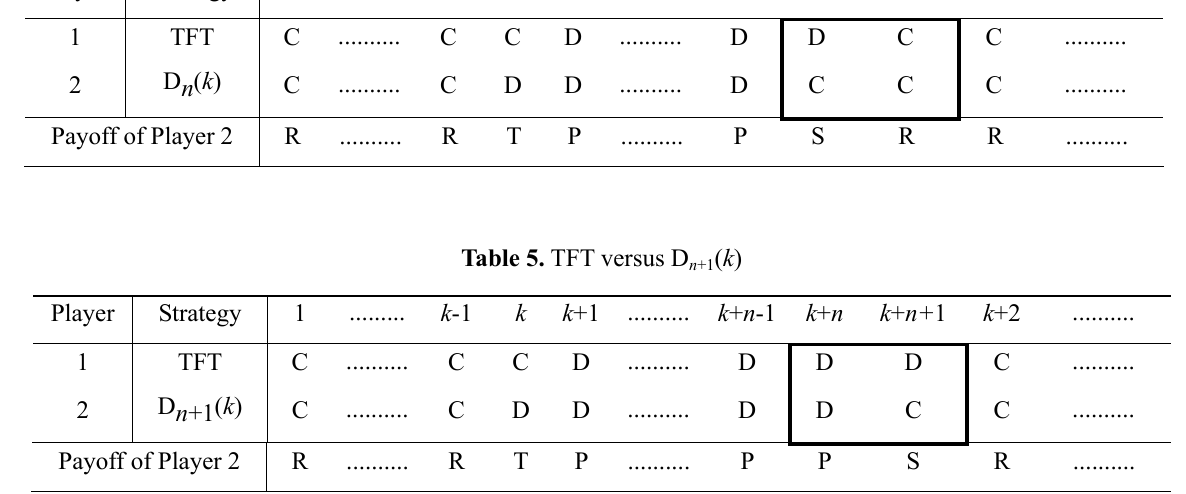
Table 4. TFT versus D